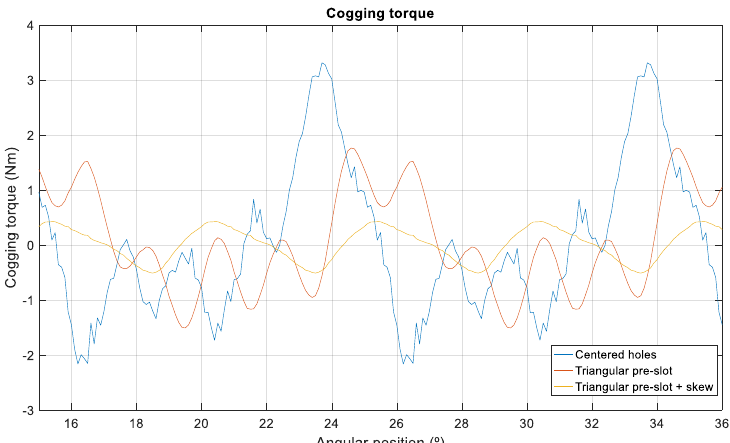
Figure 15. Cogging torque of the centered holes PMSG model, triangular pre-slot model and triangular pre-slot model with skewing (with manufacturing errors).